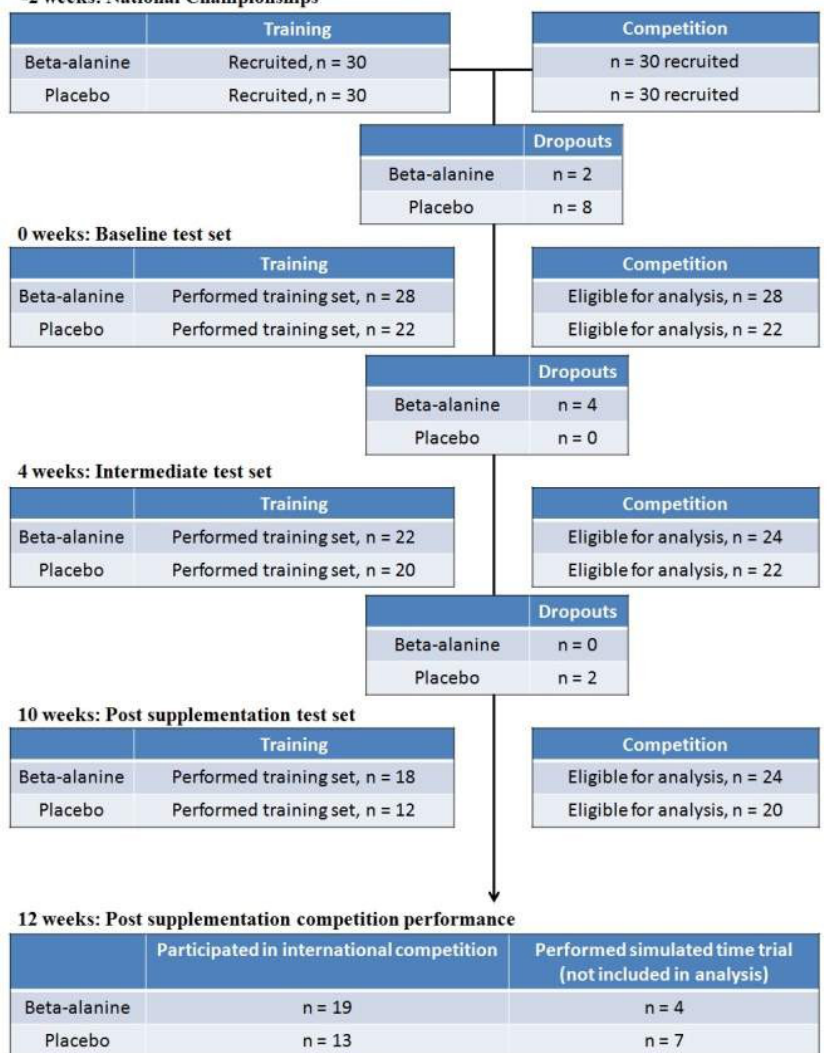
Figure 2. Changes in subject numbers and International Point Score (IPS) profiles over